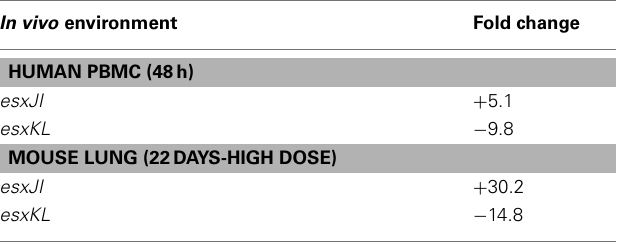
Table 4 | esxJI and esxKL mRNAs are differentially expressed in different in vivo